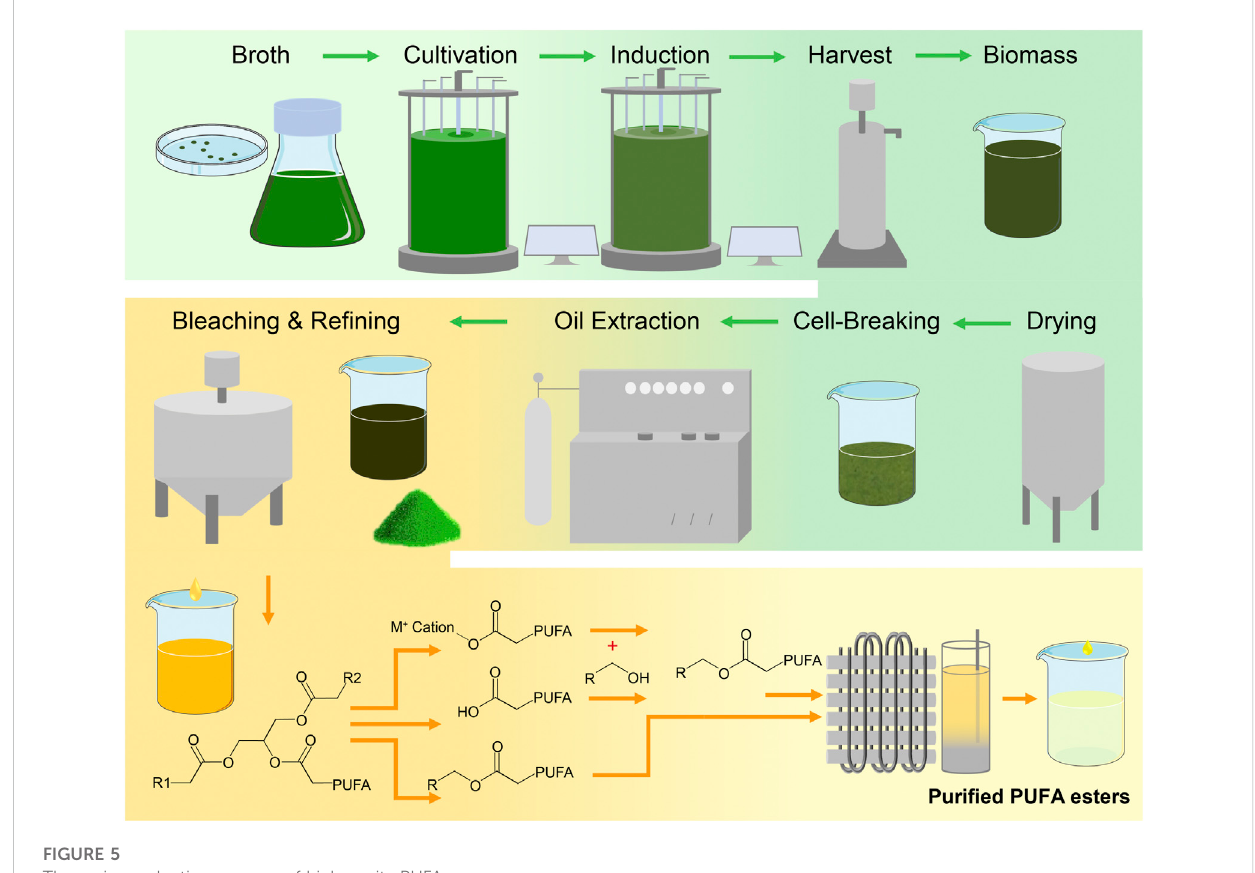
FIGURE 5 The main production process of high-purity